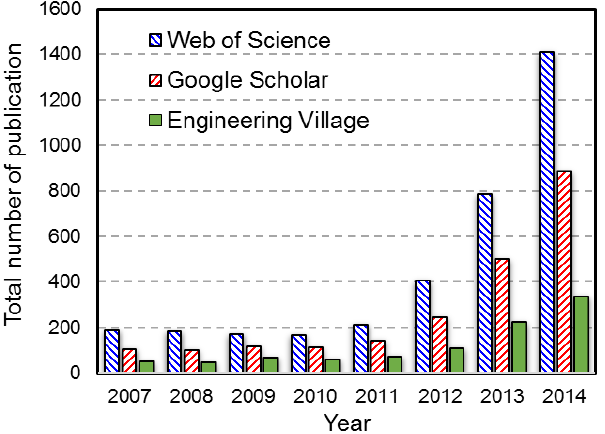
Figure 1. The number of papers published with a title containing or a topic pertaining to molybdenum disulfide (MoS 2